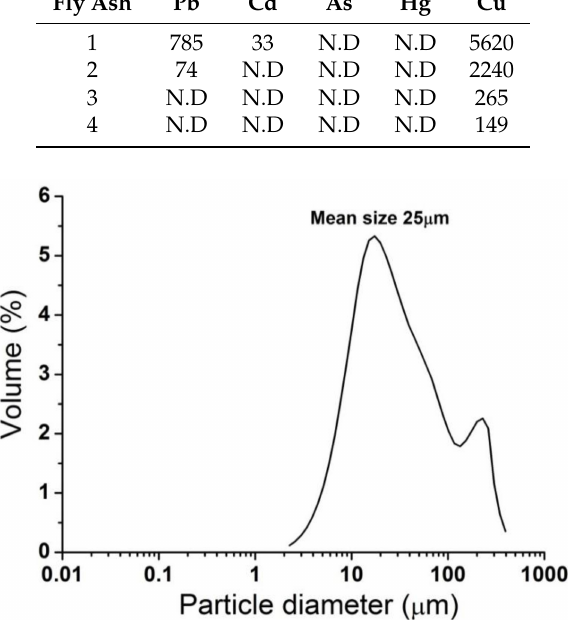
Figure 2. Particle size distribution of fly ash